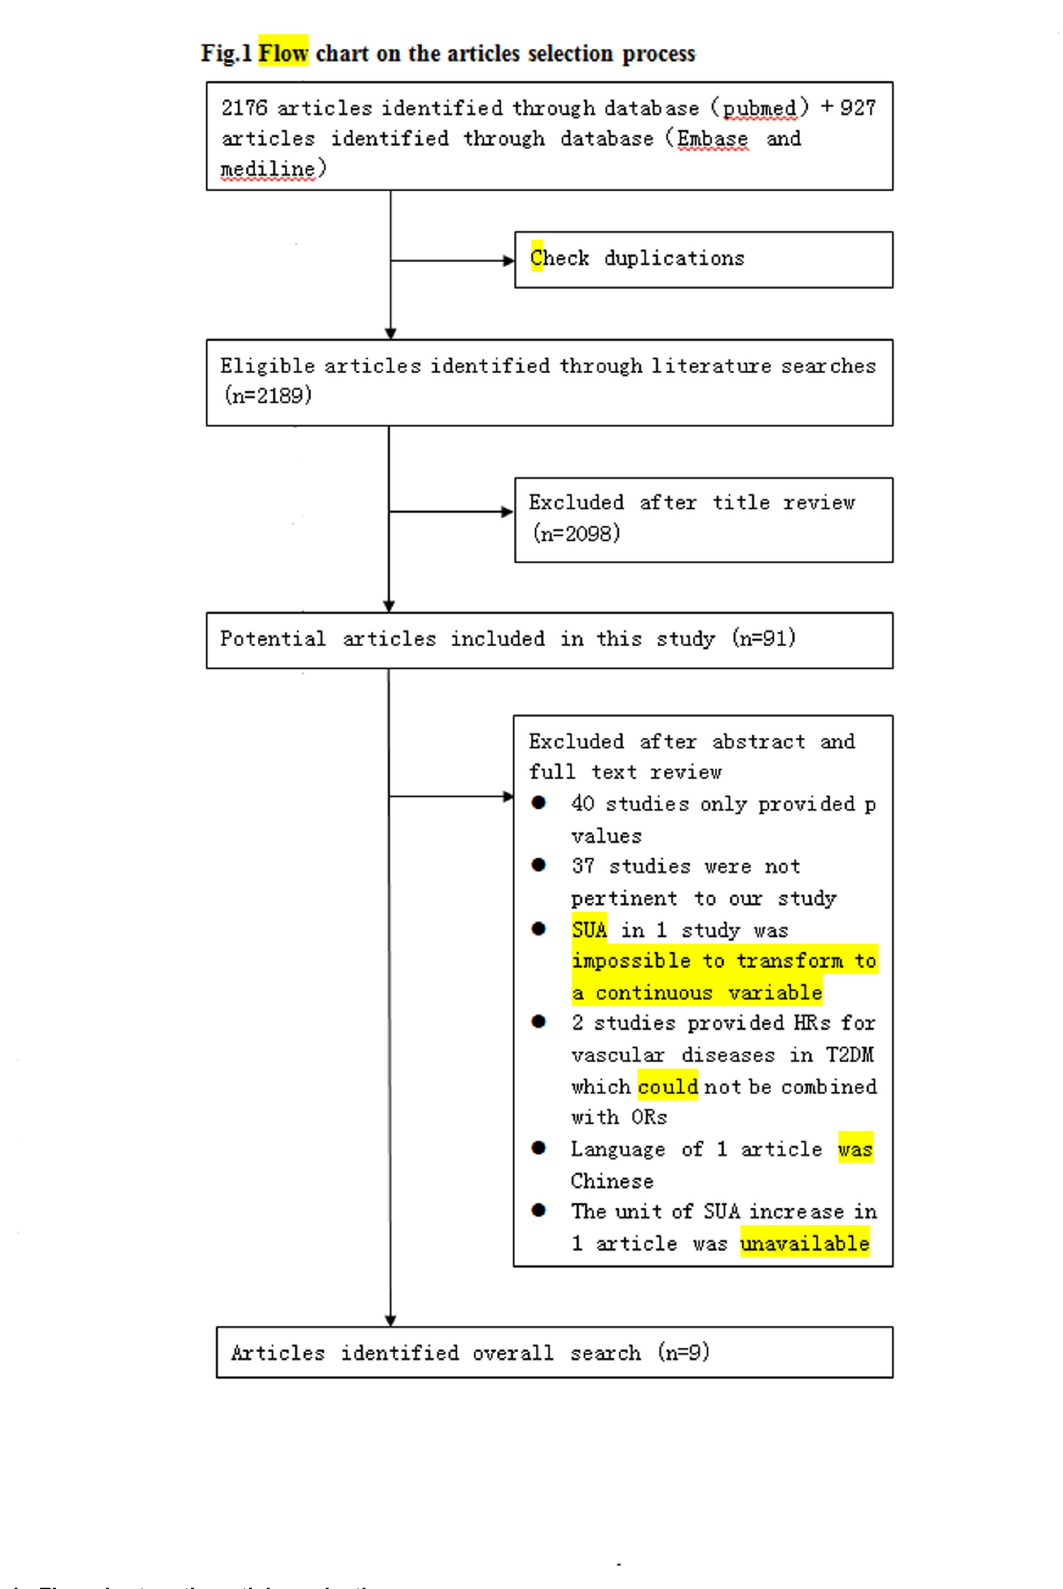
Figure 1. Flow chart on the articles selection process.